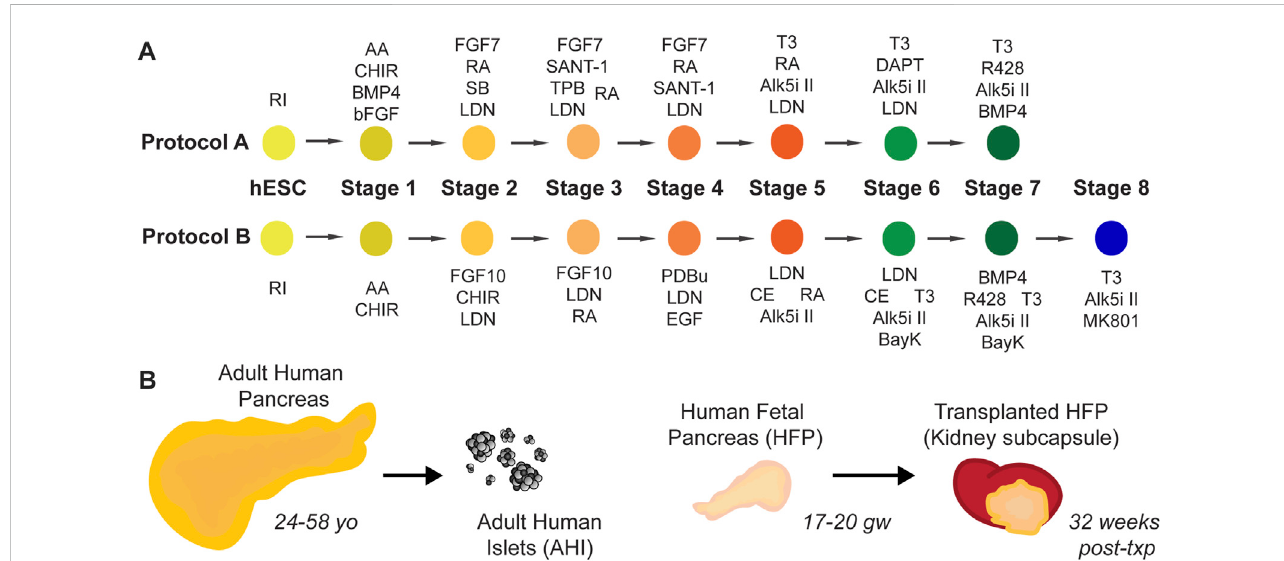
Resources used in this study. (A) Schematic diagrams for two SC-islet differentiation protocols, Protocol A ( “ A ” ) and Protocol B ( “ B ” ). Full details of these protocols are detailed in Supplemental Tables 1-3. (B) Adult human pancreas tissue (age range 24 – 58 years old), isolated adult human islets ( “ AHI ” ), human fetal pancreas ( “ HFP ” ) (age range 17 – 20 gestational weeks) and matured HFP grafts (32 weeks post-transplant) are used in this study for assessment of gene expression, protein localization, and